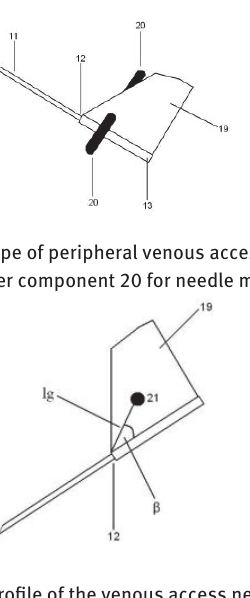
Figure 7B: A side profile of the venous access needle of Fig 7A, where the position of the guider is labelled the